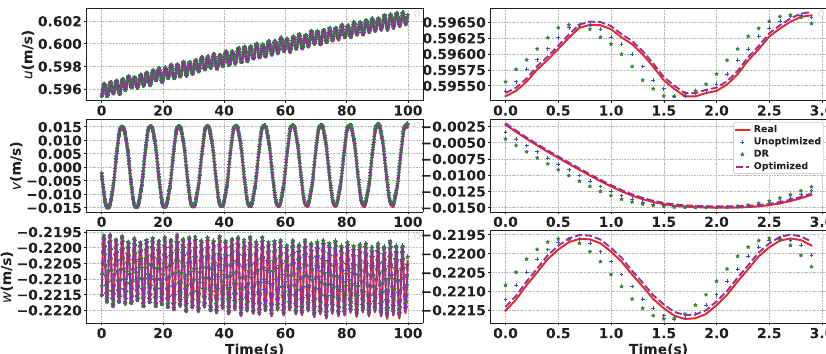
Figure 11. Identification result of AUV velocity.